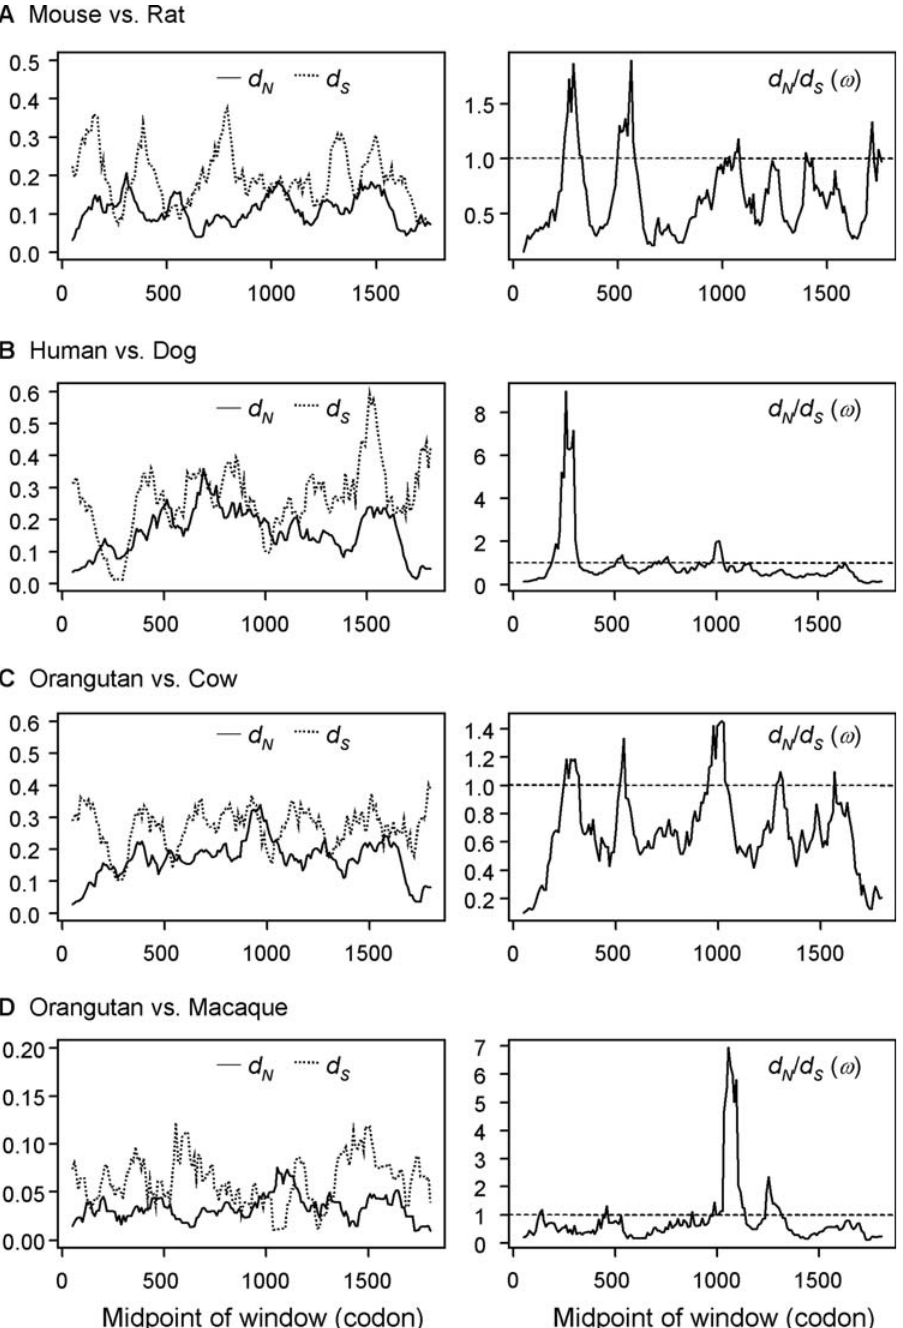
Figure 1. Sliding-window plots of dˆ S , dˆ N and vˆ = dˆ N / dˆ S in pairwise comparisons of the BRCA1 genes from mammalian species. The window size is 100 codons, and the offset between windows is one codon.